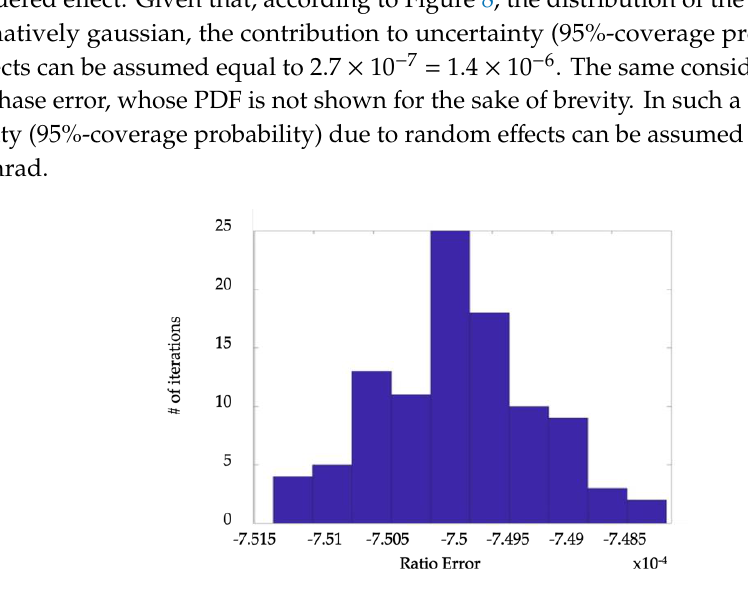
Figure 7. PDF of the ∆ ϕ calculated from the metrological characterization of the items.